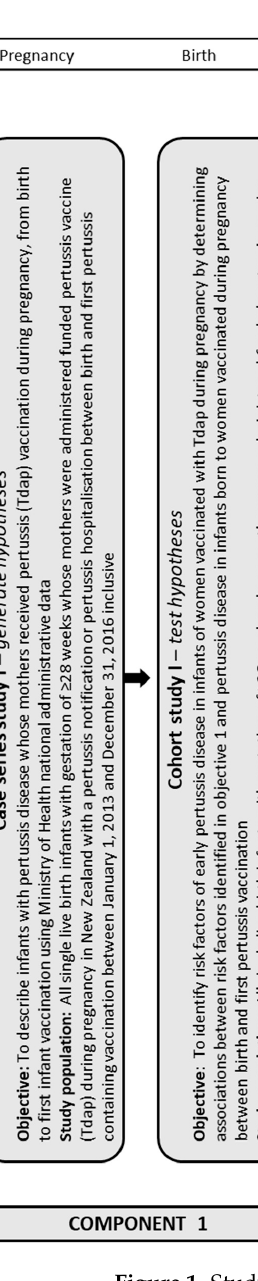
Figure 1. Study design and study objectives.